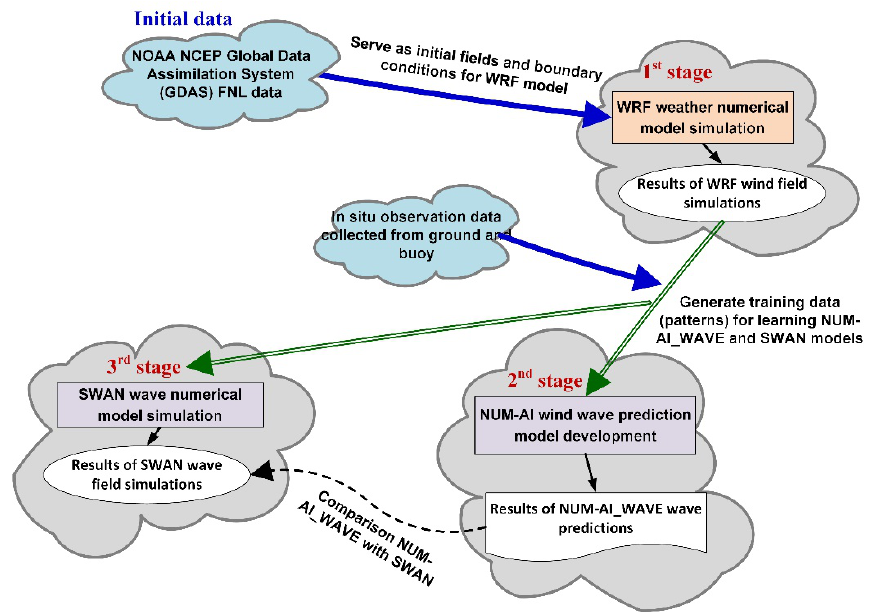
Figure 1. Methodology of the proposed NUM–AI-based wind–wave models.